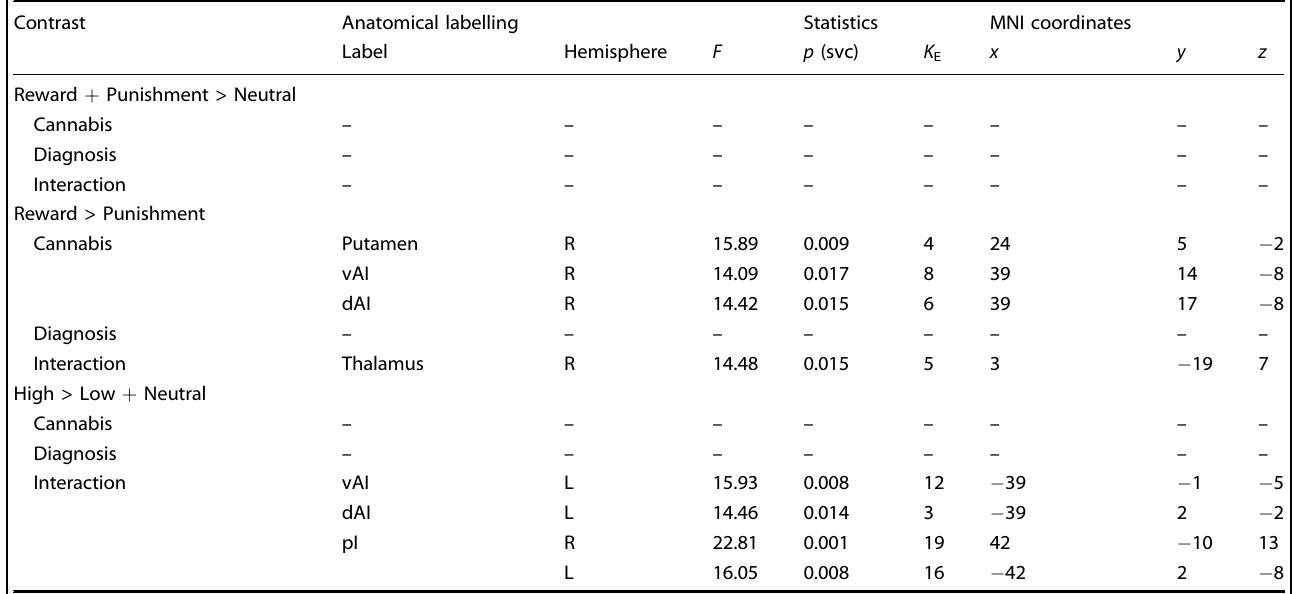
Table 3. Region of interest (ROI) main analysis displaying the effects of cannabis and schizophrenia on each contrast of interest as well as the cannabis by schizophrenia interactions.